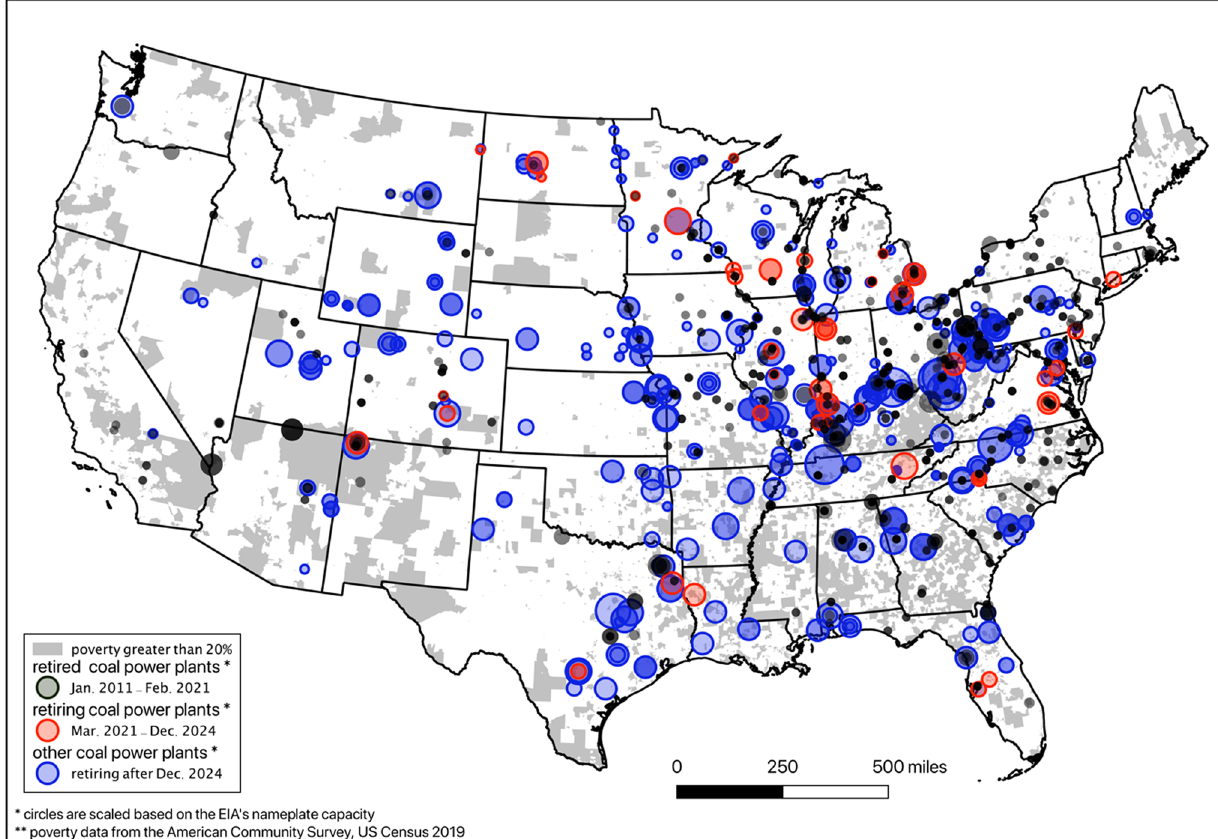
Fig. 1 Coal power plant retirement status